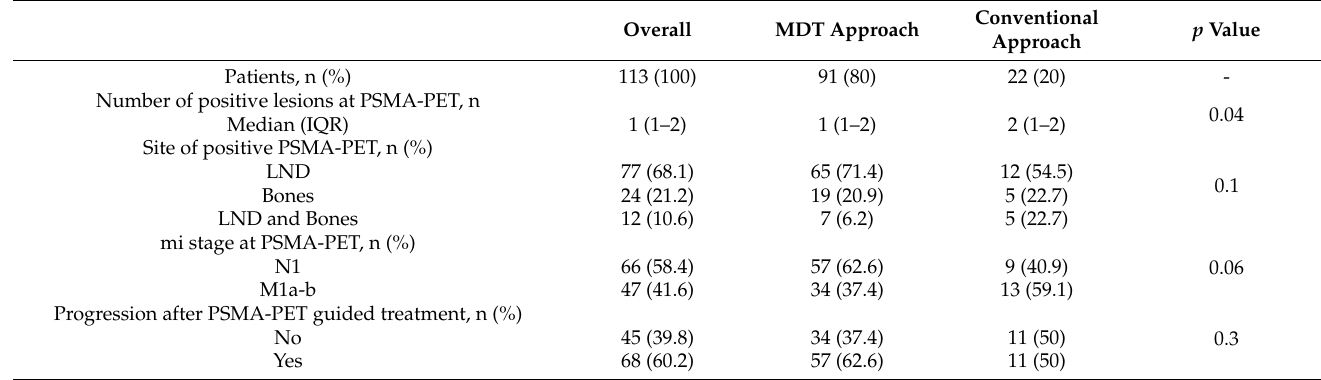
Table 2. PSMA-PET results and oncologic outcomes after PSMA-guided salvage treatments stratified according to type of treatment (namely, MDT vs. conventional